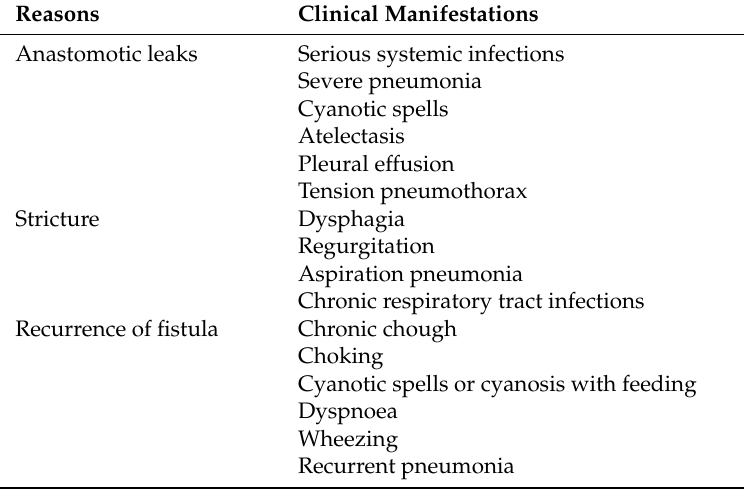
Table 1. Reasons for the short-term pulmonary impairments and clinical manifestations in children with repaired congenital esophageal atresia and tracheoesophageal